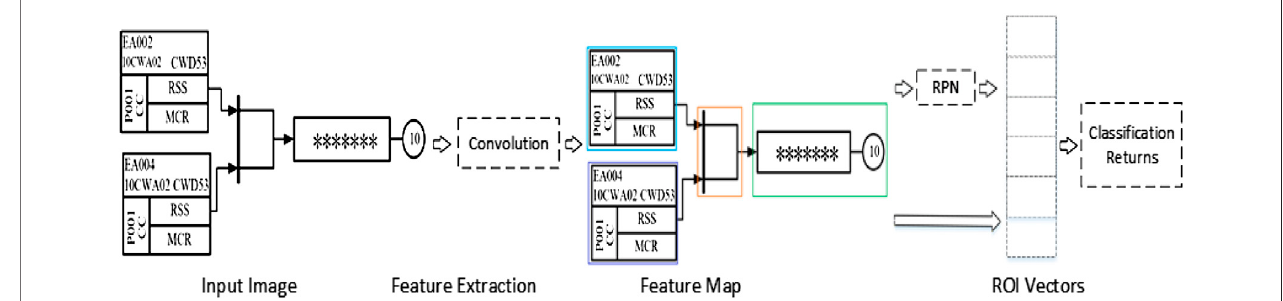
FIGURE 2 | Faster R-CNN basic network framework.